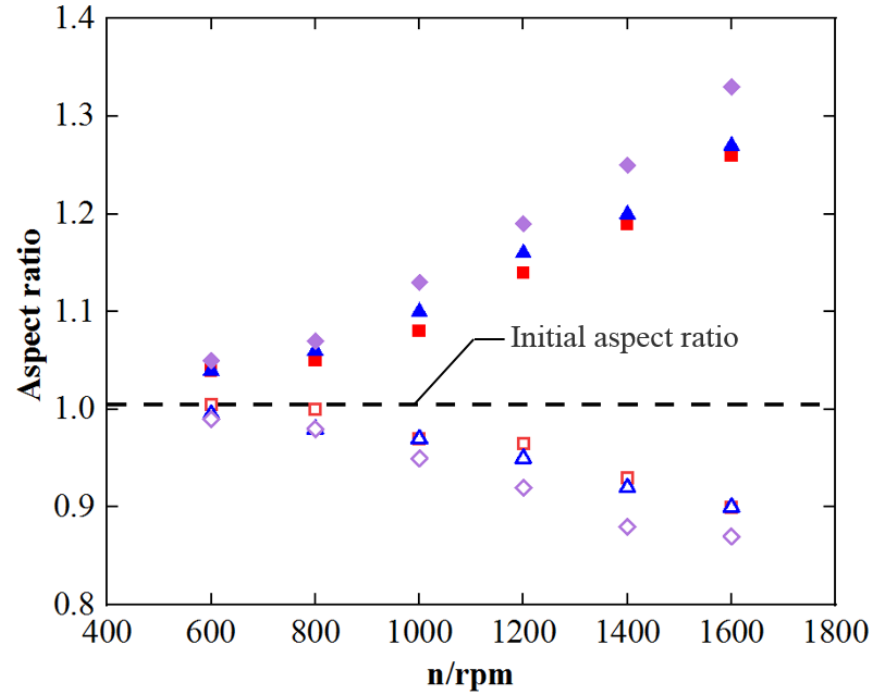
Figure 7. The maximum (closed) and minimum (open) aspect ratios of the droplet as a function of the rotating speed for the change rate of spiral radius of 0.637 (square), 0.796 (triangle), and 1.061 (diamond) mm/rad ( D = 0.3 mm, µ o = 12.60 mPa · s).